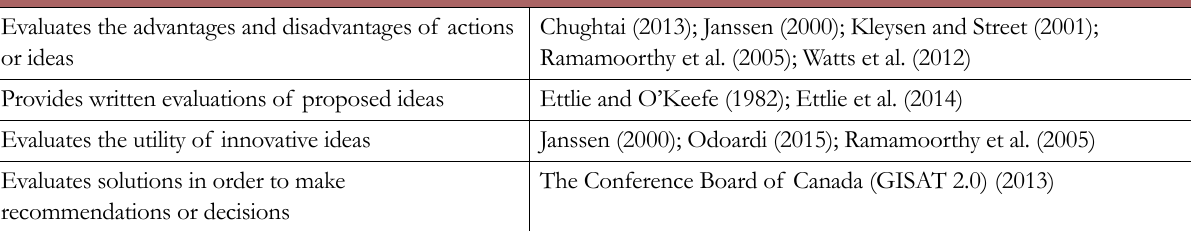
Table 10. Behaviours showing